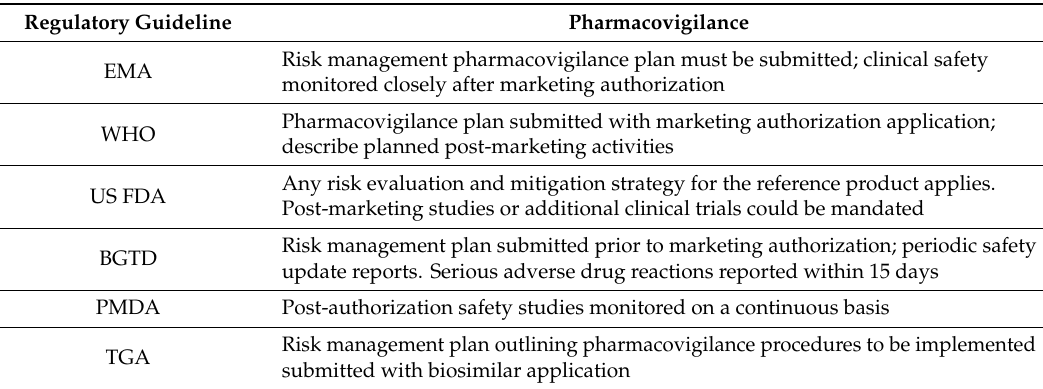
Table 5. Comparative overview between the regulatory guidelines for pharmacovigilance between EMA, WHO, US FDA, BGTD, PMDA, and